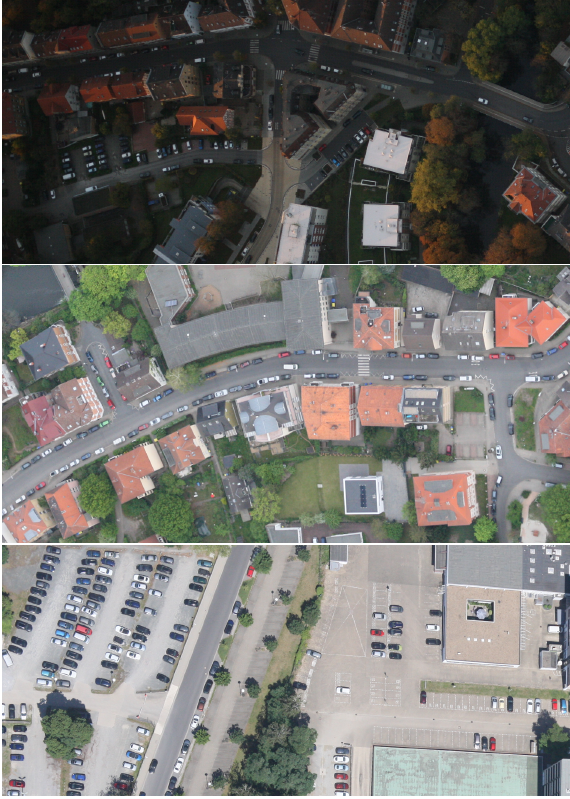
Figure 6. Exemplary image crops (from top to bottom): urban – low illumination, suburban – no sun, industrial –